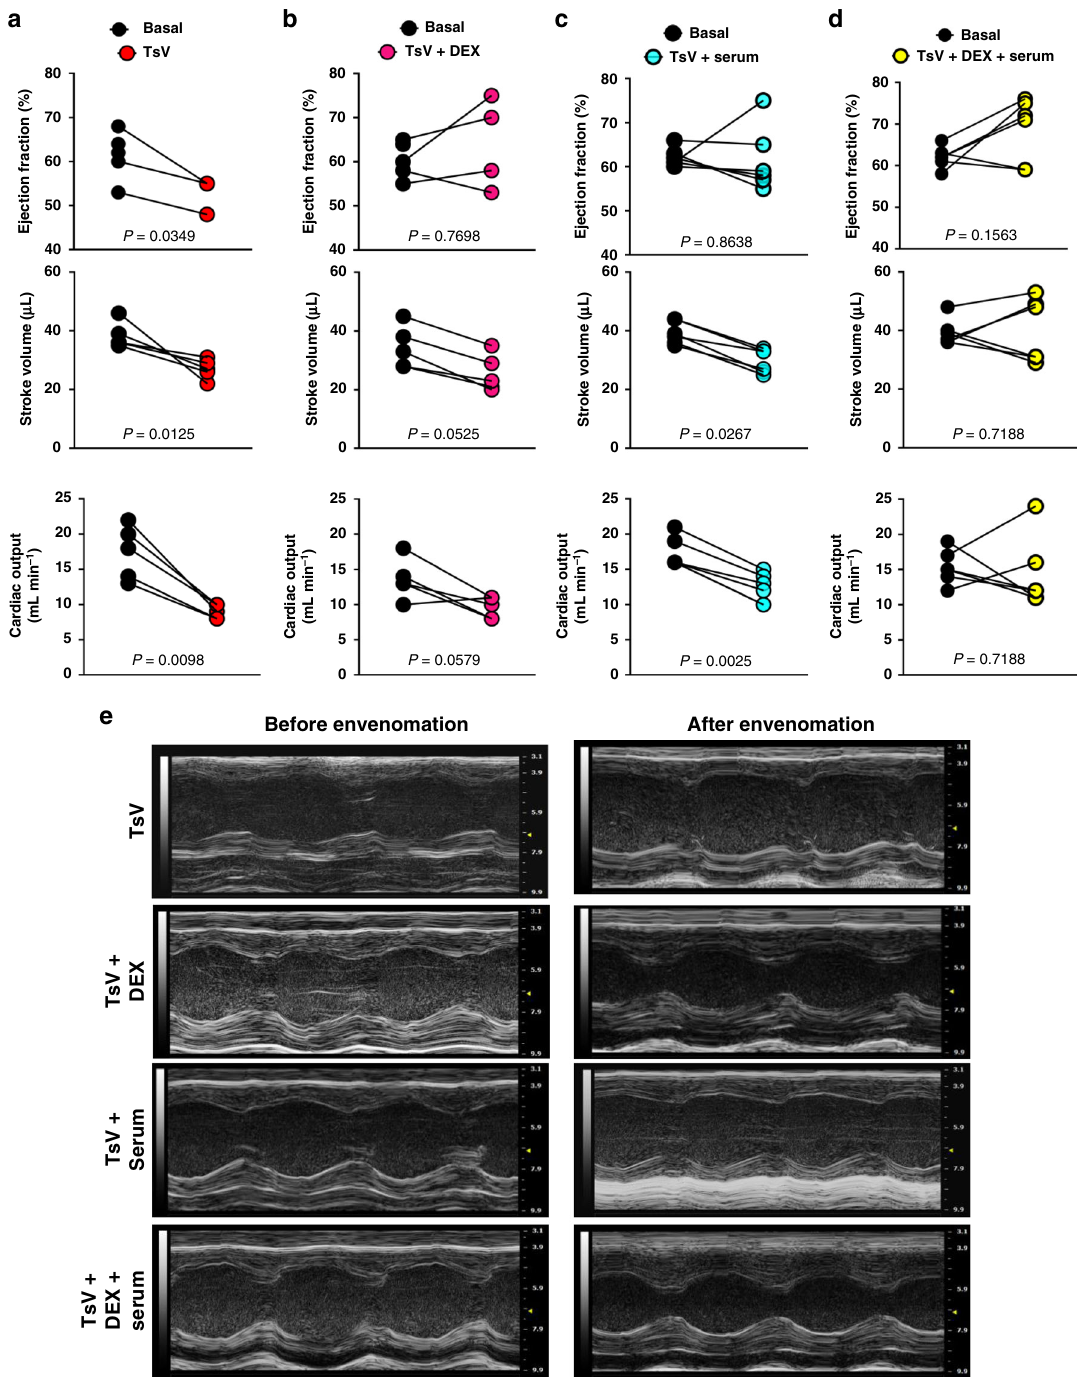
Fig. 4 Ef fi cacy of therapy with dexamethasone and/or antiscorpionic serum. Ejection fraction (EF), stroke volume (SV), and cardiac output (CO) of C57Bl/6 mice were submitted to echocardiography before (basal) and 45 min after inoculation with the venom. a TsV only; b TsV plus DEX (5 mg kg − 1 i.p.)/15 min after the venom; c TsV plus antiscorpionic serum (30 µ l/1 mg/ml/animal)/30 min after the venom; or d TsV plus DEX (5 mg kg − 1 i.p.)/15 min after the venom followed by antiscorpionic serum (30 µ l/1 mg/ml/animal)/15min after DEX ( n = 5 – 6, one experiment). e Representative M-mode image of echocardiographs obtained from the above-mentioned groups. Data are expressed as means ± SEM. Paired t test was applied to evaluate statistical signi fi cance. Differences were considered signi fi cant if P <